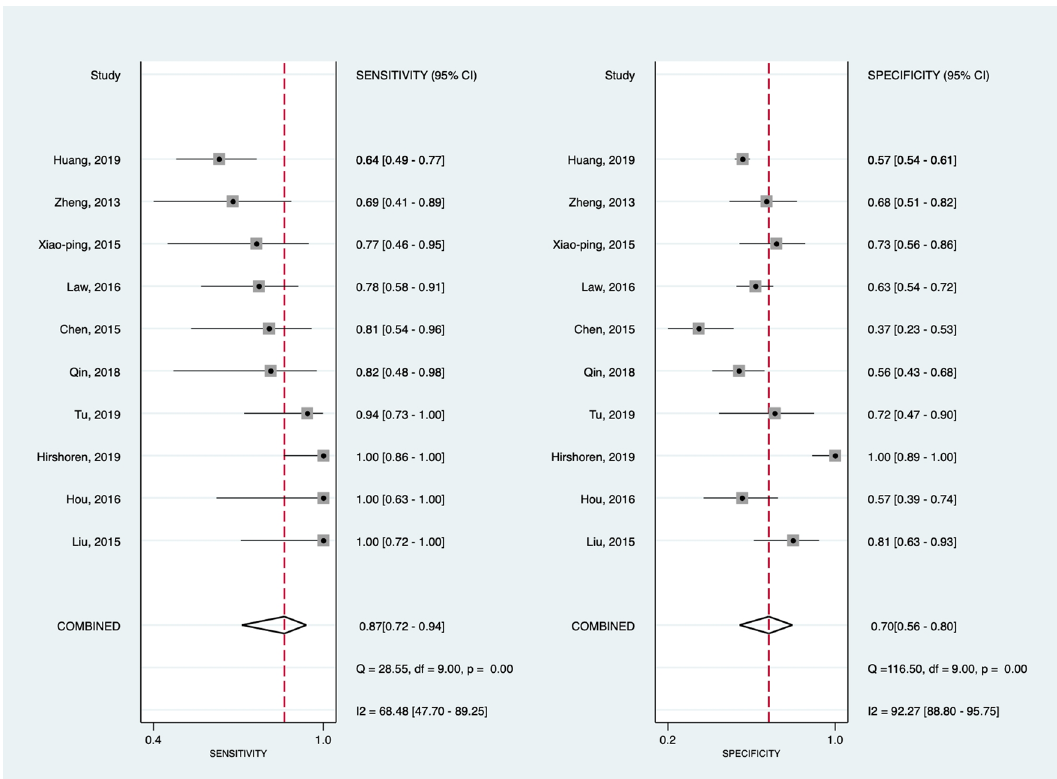
Figure 2. Coupled forest plots illustrating pooled sensitivity and specificity of pretreatment ADC for predicting treatment response in patients with nasopharyngeal carcinoma. Horizontal lines indicate 95% CIs of each study.